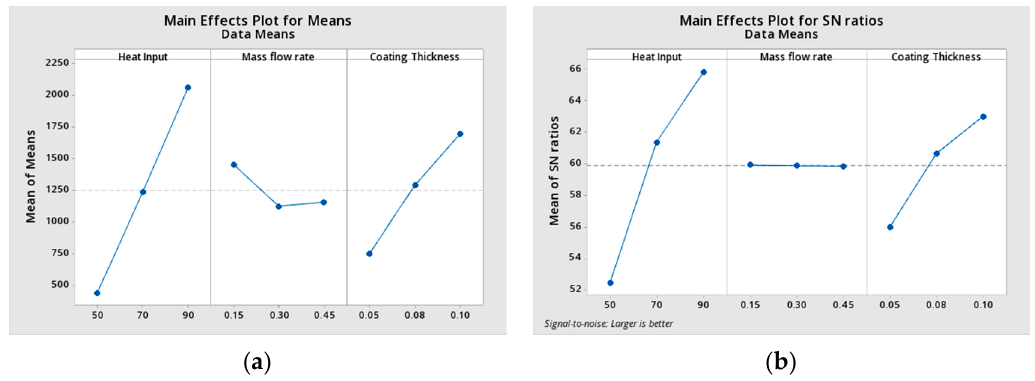
Figure 25. Taguchi Analysis for Overall heat transfer Versus Heat Input, Mass Flow Rate and Coating Thickness. ( a ) Main Effects Plot for Means; ( b ) Main Effects Plot for SN ratios